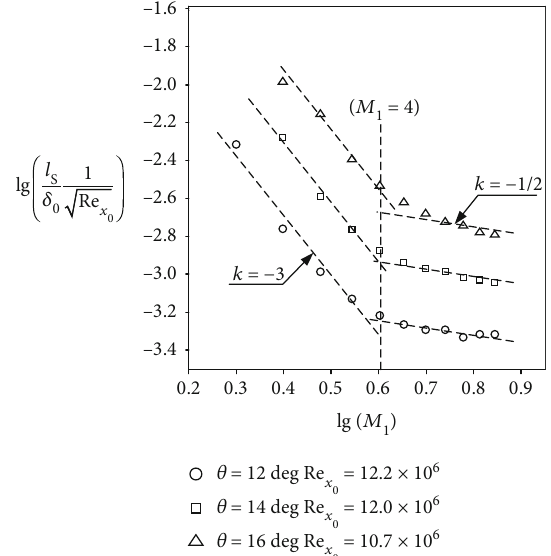
Figure 9: Correlation of the Mach number with the separation length.